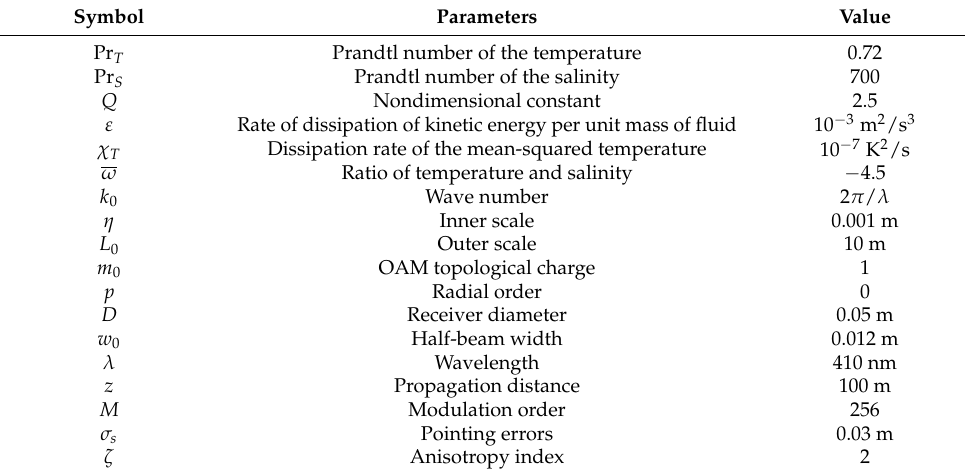
Table 1. Major system parameters.